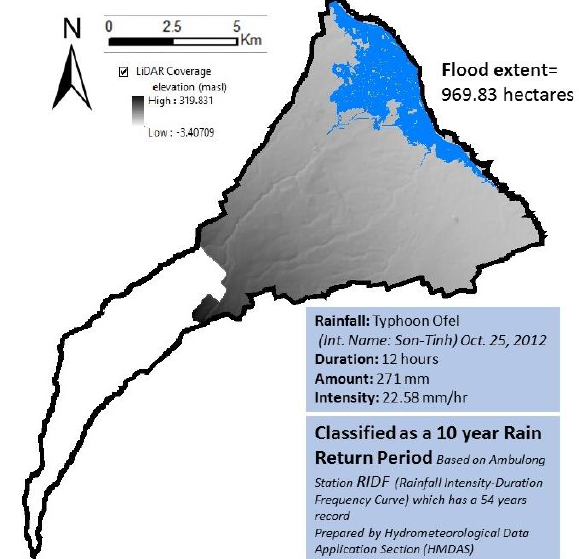
Figure 10. Flood extent map using the 2D unsteady flow